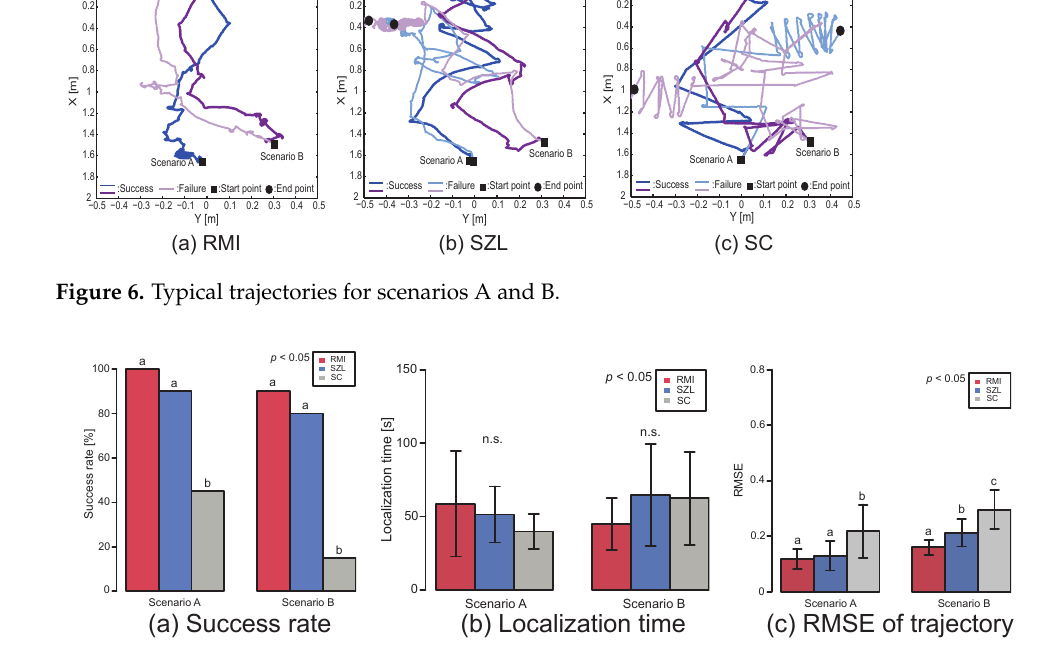
Figure 7. Results of 20 repeated experiments. Results of ( a ) search success rate, ( b ) localization time, and ( c ) RMSE for trajectory. Groups sharing the same letter are not significantly